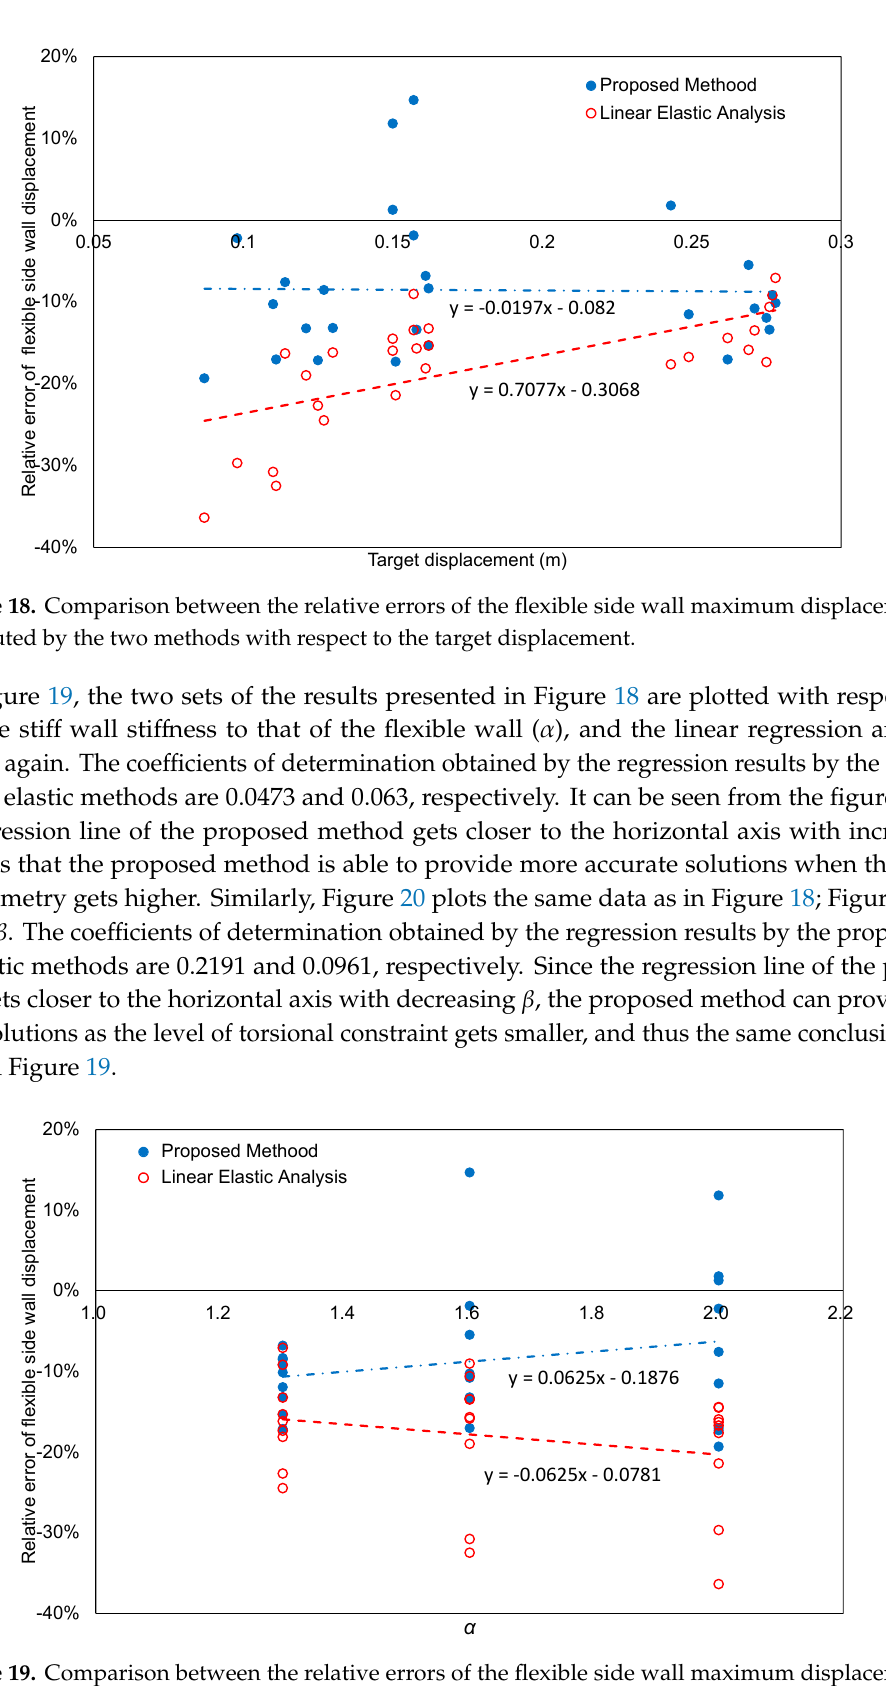
14.39 Figure 18 plots the relative errors of the flexible side wall displacement of all 27 data points listed in Tables 4 to 6 with respect to the target displacement ( Δ cen_TH ) for the proposed method and the linear elastic response. A linear regression analysis is performed on each set of the results computed with the two methods by having the target displacement as an independent variable, and their regression lines are drawn in the figure. The coefficients of determination obtained by the